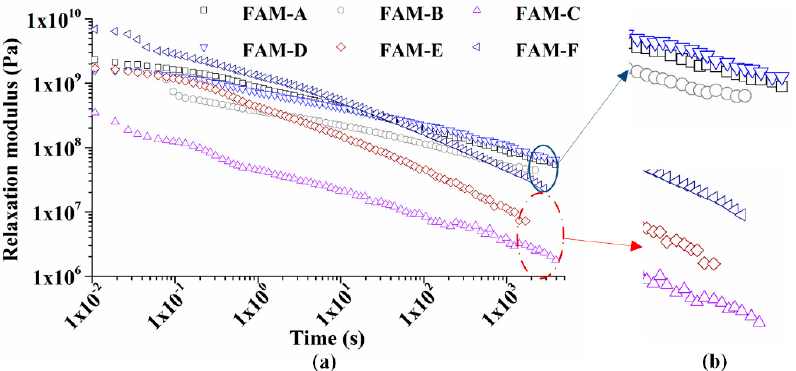
◦ C: ( a ) whole image, and ( b ) enlarged